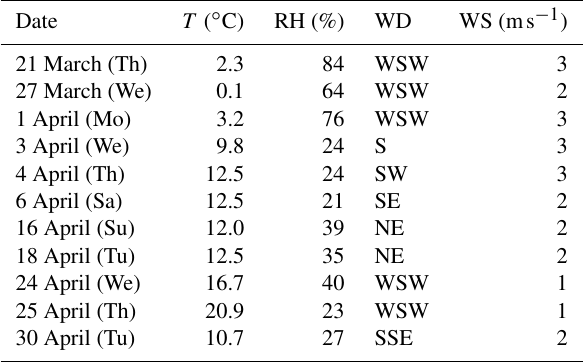
Table A2. Basic meteorological data for the days of the field cam- paign: surface air temperature ( T ), relative humidity (RH), wind speed (WS) and wind direction (WD) at local noon. The meteo- rological data refer to one of the observational sites in the city of St. Petersburg (http://rp5.ru/Weather_archive_in_Saint_Petersburg,